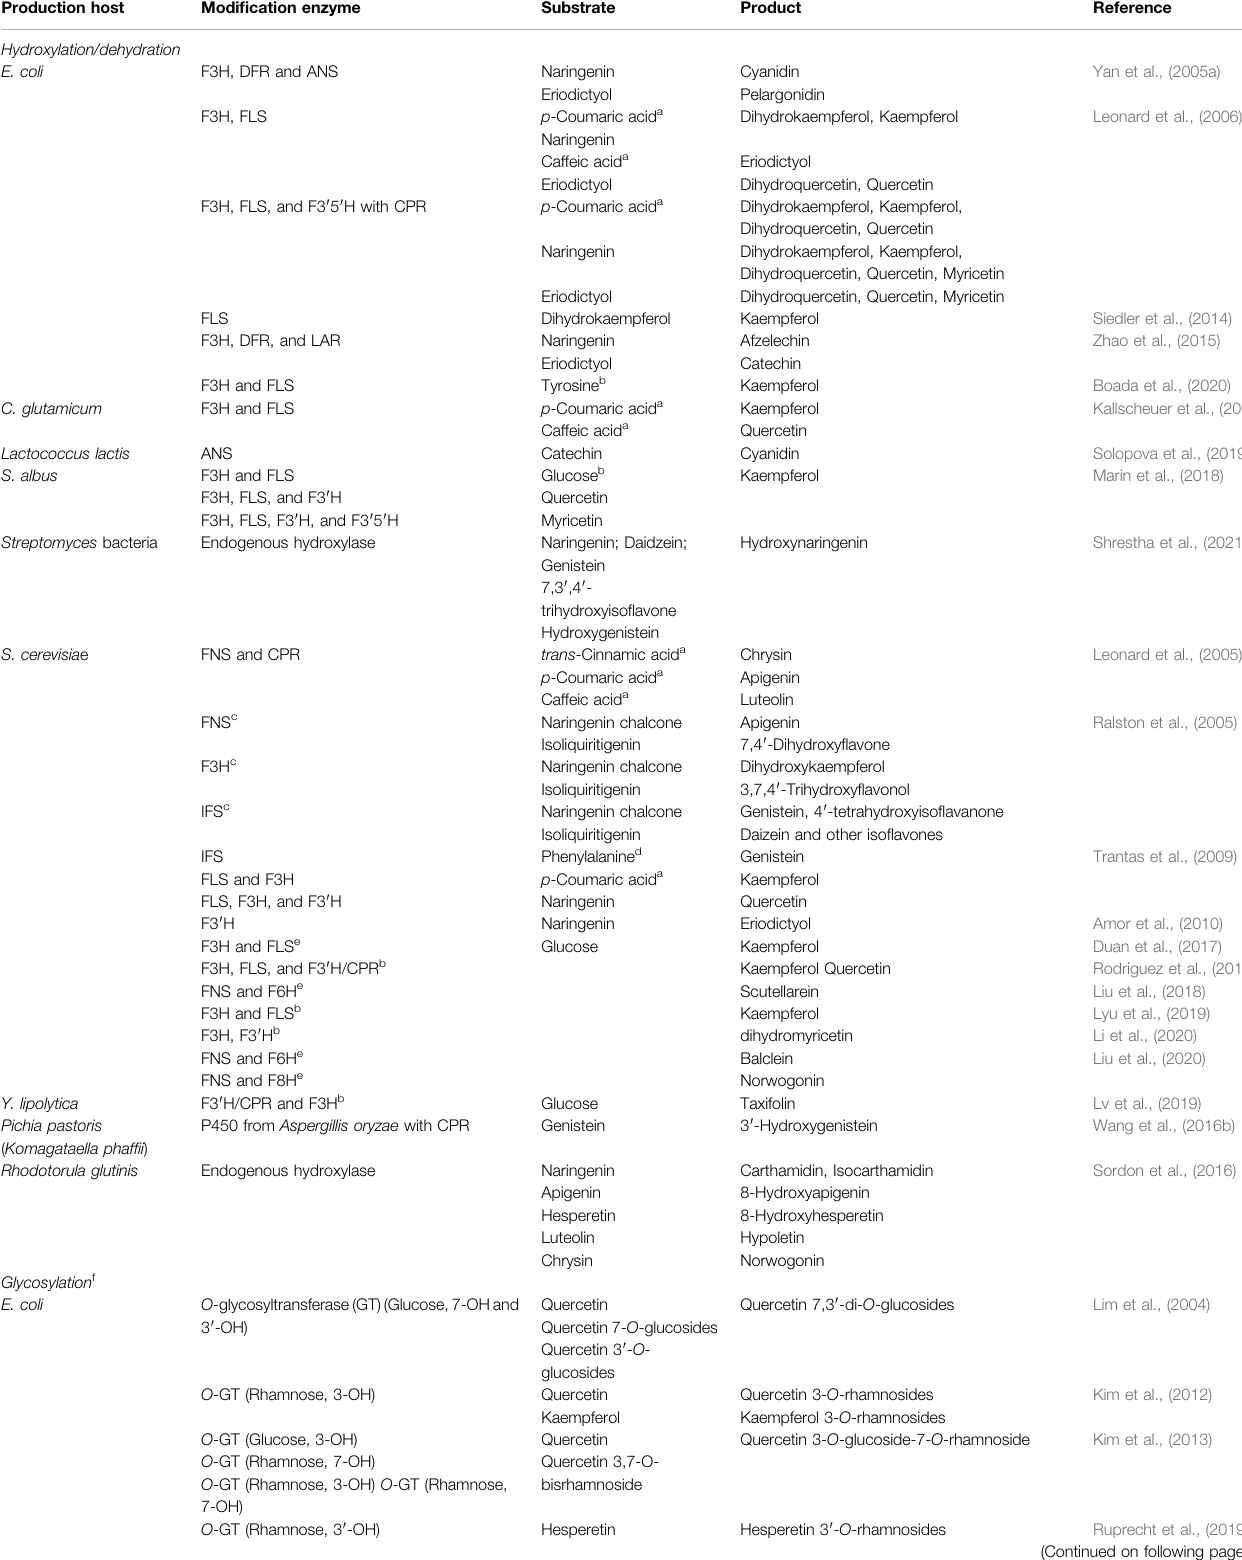
TABLE 3 | Microbial production of diversi fi ed fl avonoids. Production